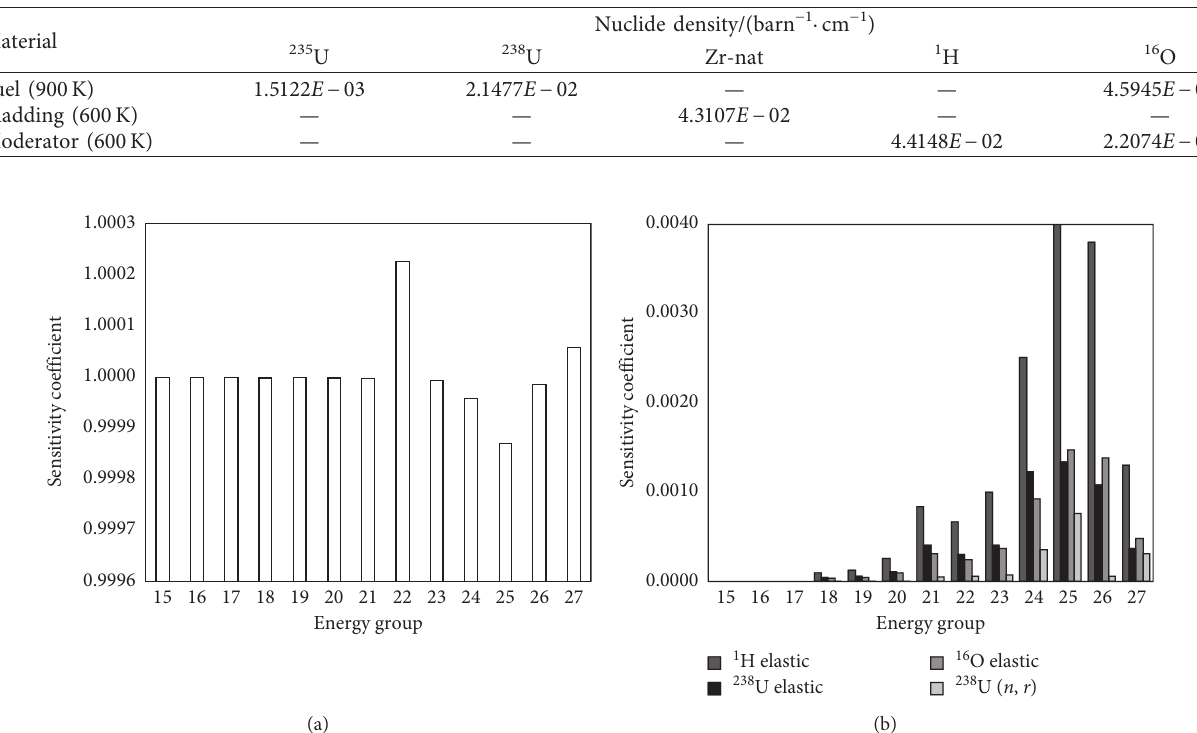
Figure 6: The top five most sensitive sources to the 235 U effective resonance scattering XS and the corresponding implicit sensitivity coefficients. (a) Sensitivity coefficient to 235 U elastic scattering. (b) Sensitivity coefficients to other four